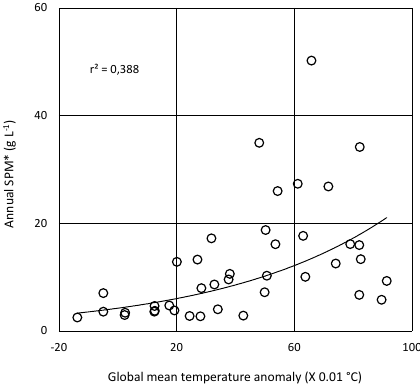
Figure 15. Variations of SPM ∗ against the global mean temperature